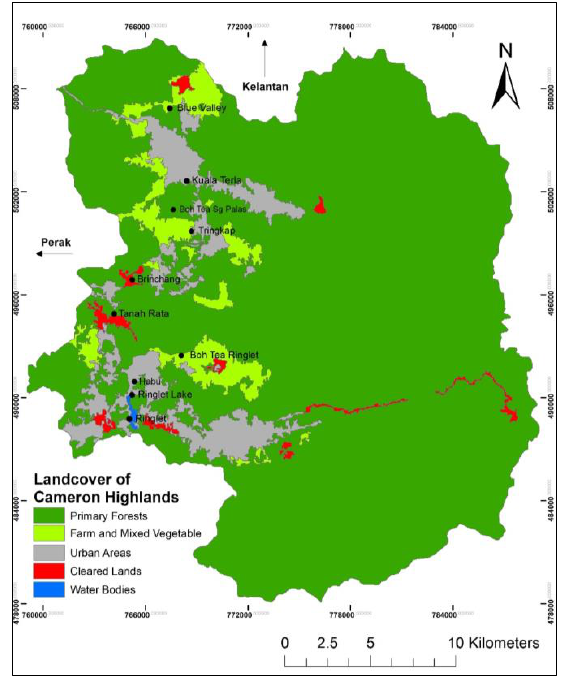
Figure 4. Land cover classification of Cameron Highlands in 2009.